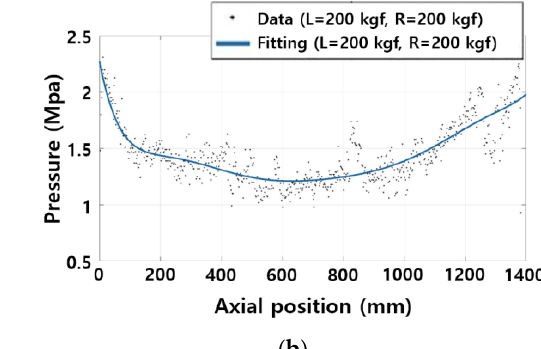
Figure 3. Pressure distribution along roller during simulation (FEM): ( a ) Imprinting module of conventional R2R NIL used in simulation (FEM); ( b ) Distributed pressure on the contact area.